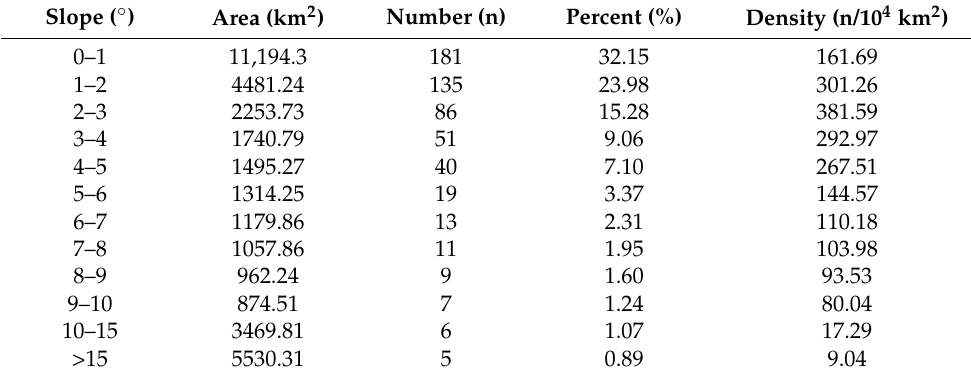
Table 2. Relationship table of settlement distribution and